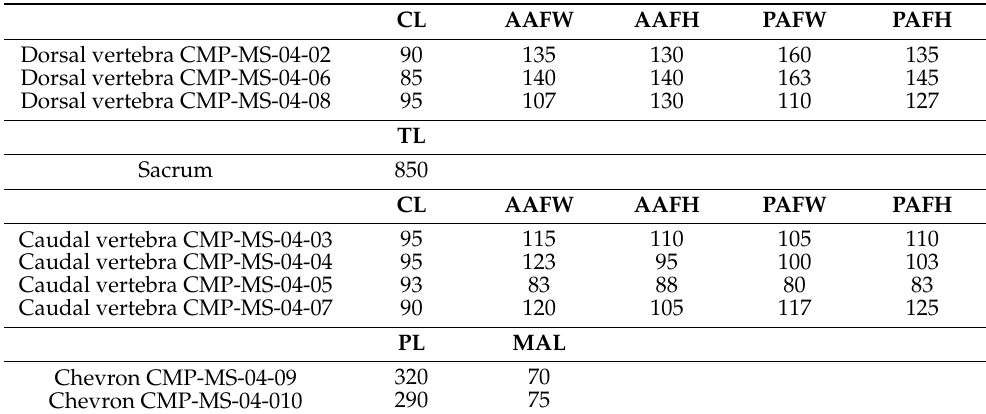
Table 1. Measurements (in mm) of the axial elements of the specimen of Iguanodon bernissartensis CMP-MS-04. Abbreviations: AAFH: Anterior articular facet height; AAFW: Anterior articular facet width; CL: Centrum length; MAL: Maximum anteroposterior length; PAFH: Posterior articular facet height; PAFW: Posterior articular facet width; PL: Proximodistal length; TL: Length (total).